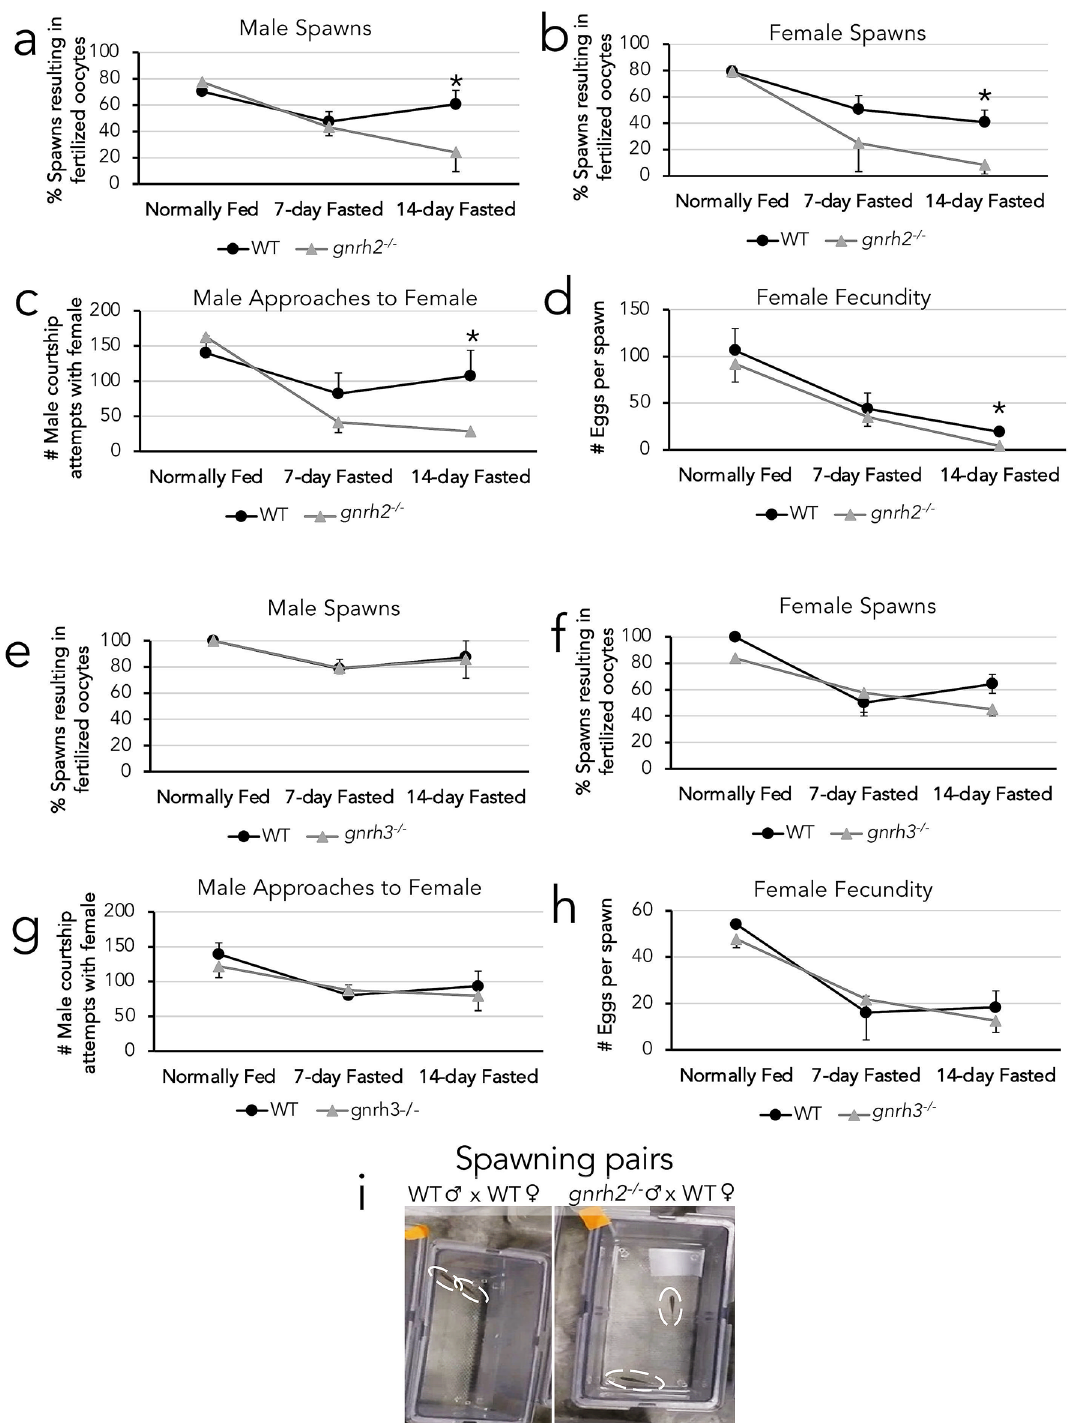
Figure 6. Reproductive outputs of male (n = 8–10 per group) and female (n = 5–8 per group) WT, gnrh2, and gnrh3 fish undergoing 0, 7, and 14-day fasting, including WT and gnrh2 −/− comparisons of male spawning percentages (a), female spawning percentages (b), quantification of male courtship attempts with female partners (c), and female fecundities (d). WT and gnrh3 −/− comparisons of male spawning percentages (e), female spawning percentages (f), quantification of male courtship attempts with female partners (g), and female fecundities (h). Still image from video of spawning tanks demonstrating typical behavior of WT males chasing females and gnrh2 −/− males less frequently chasing female partners (i) All data expressed as means ± S.E.M, *P <